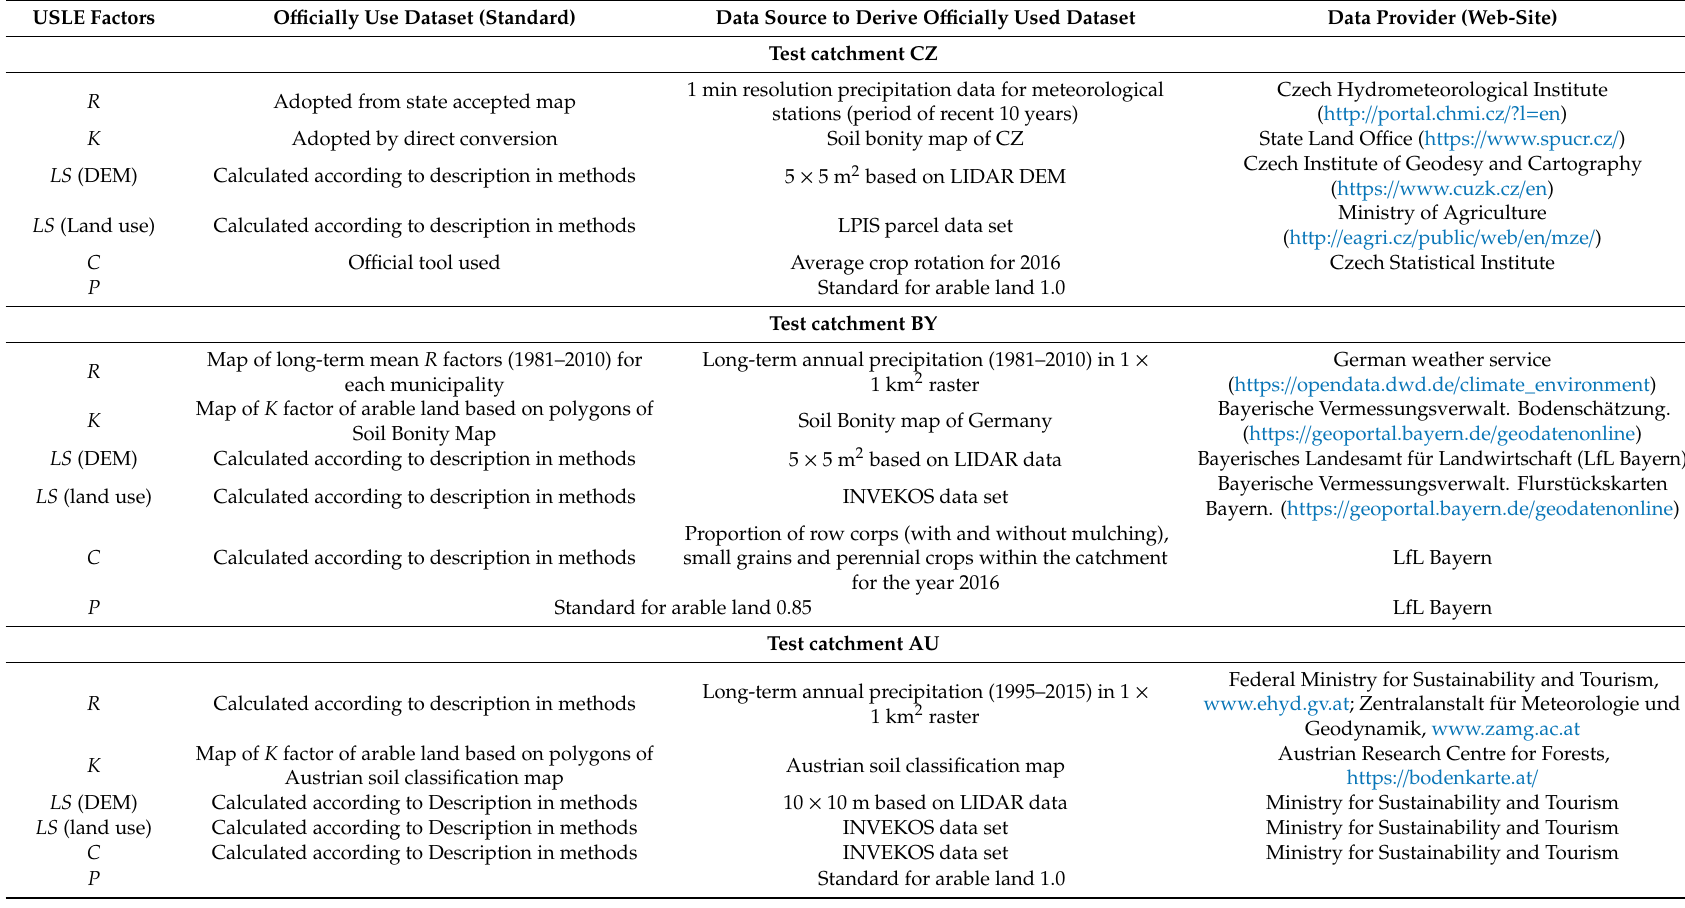
Table 2. O ffi cial datasets used by administration as well as source data to calculate the Universal Soil Loss Equation (USLE) factors. USLE Factors O ffi cially Use Dataset